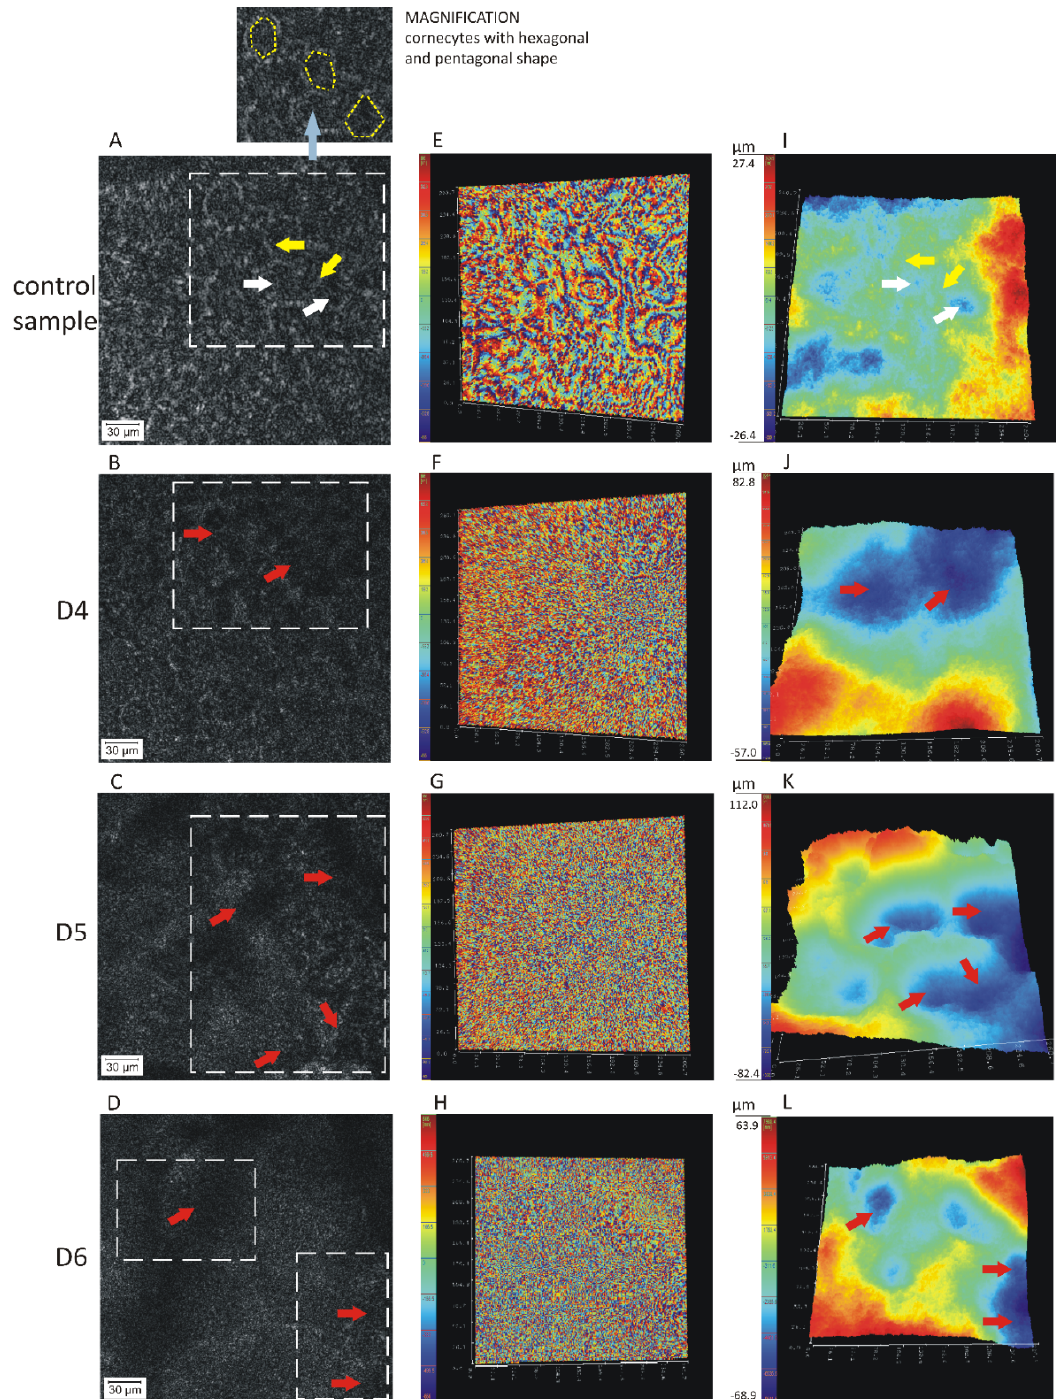
Figure 1. Intensity images ( A – D ), wrapped phase images ( E – H ), and unwrapped 3D phase images ( I – L ) of changes in the human stratum corneum structure under the influence of cyclic siloxanes (BFJ;CGK;DHL) compared with the control sample ( A , E , I ); at 20× magnification. The numbers at images I-L are determined with reference to the mean value of the respective image.